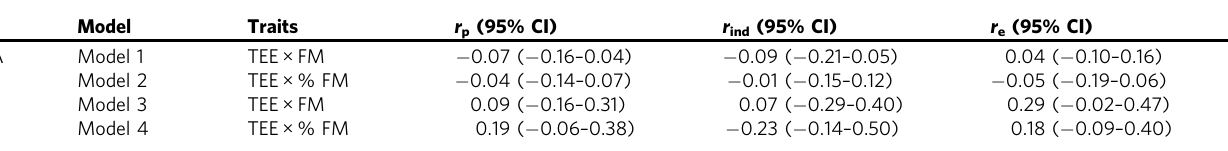
A shows result using the entire dataset ( N = 267 subjects) and B shows the results using a subset ( N = 53 subjects) for which the time between measurements exceeded 4 weeks. Correlations are presented with 95% credible intervals (CIs). TEE total energy expenditure, FM fat mass, % FM body fat